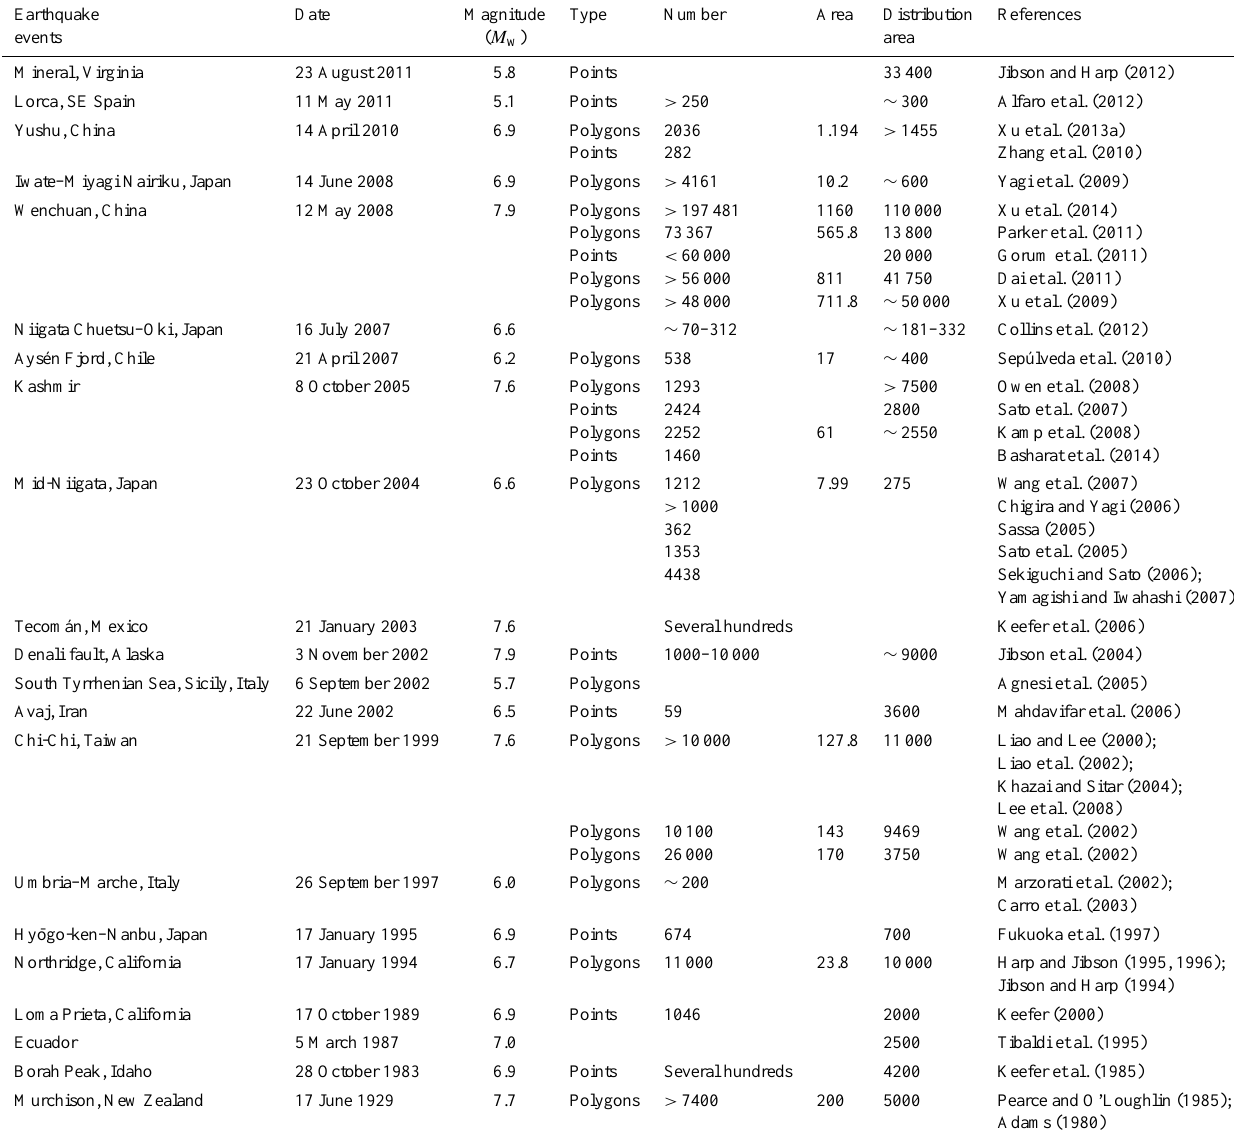
Table 1. Regional co-seismic landslide inventories related to recent earthquakes based on field investigations, GIS, and remote-sensing